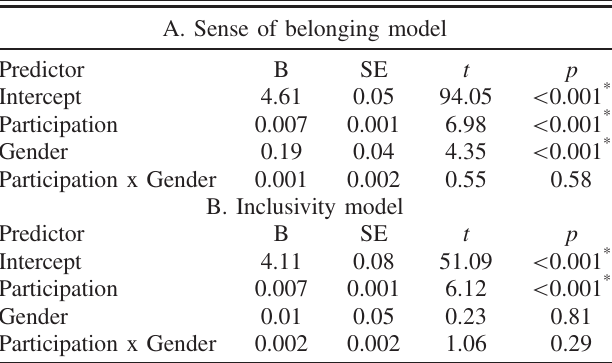
TABLE IV. Linear mixed effects regression models predicting physics post-survey